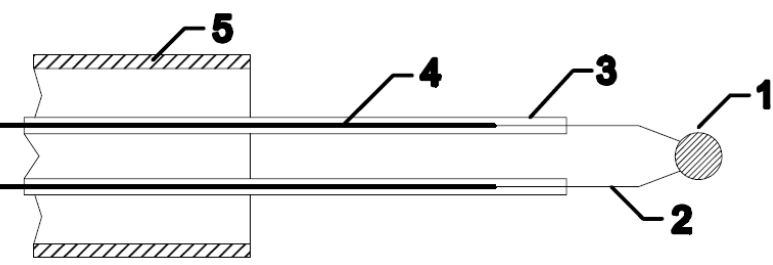
Figure 2. Thermocouple catalytic probe: 1. nickel disk; 2. thermocouple wires; 3. thin glass tube; 4. kovar wires; 5. glass tube.